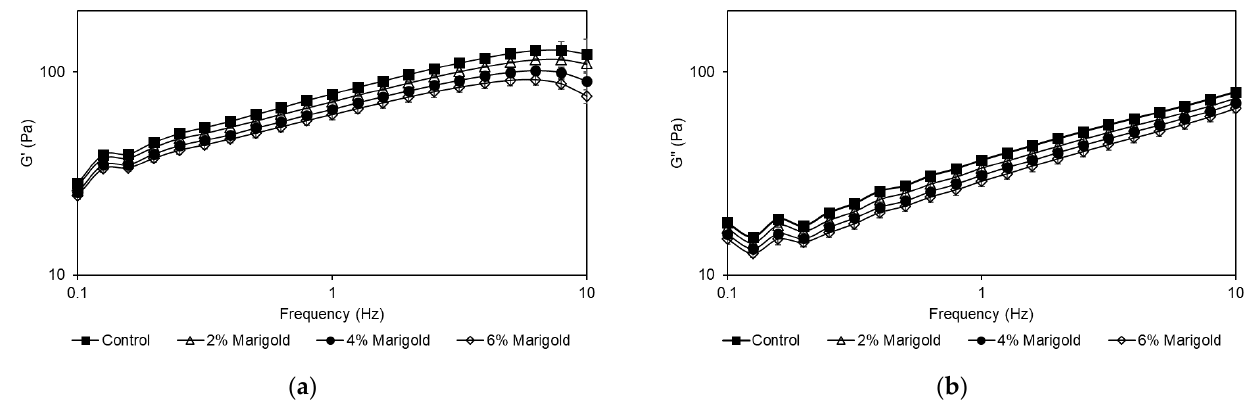
Figure 2. Changes in the viscoelastic properties of wheat flour pastes by marigold powder (G ′ ( a ) and G ″ ( b )).